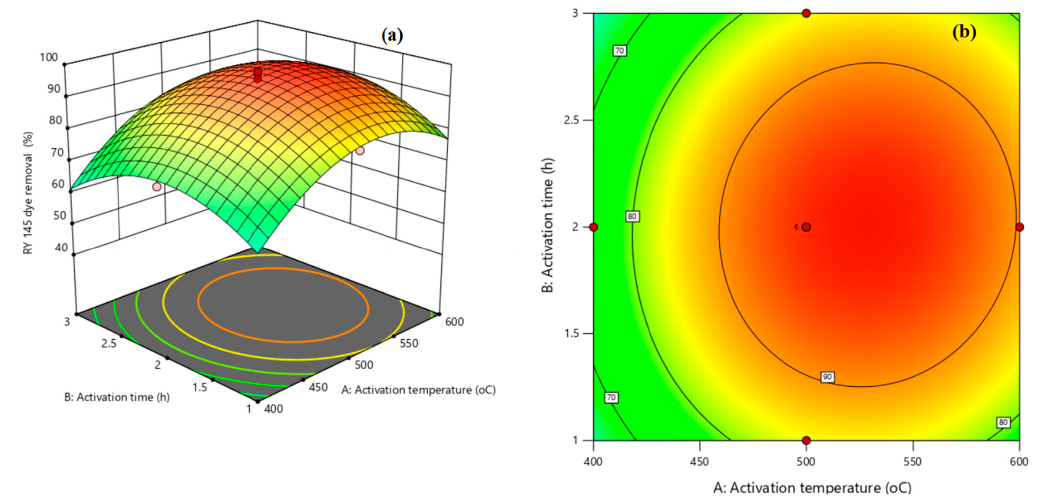
Figure 4. Response surface plots for the effects of activation temperature and heating time on the 3D response ( a ) and its corresponding counter plot ( b ).